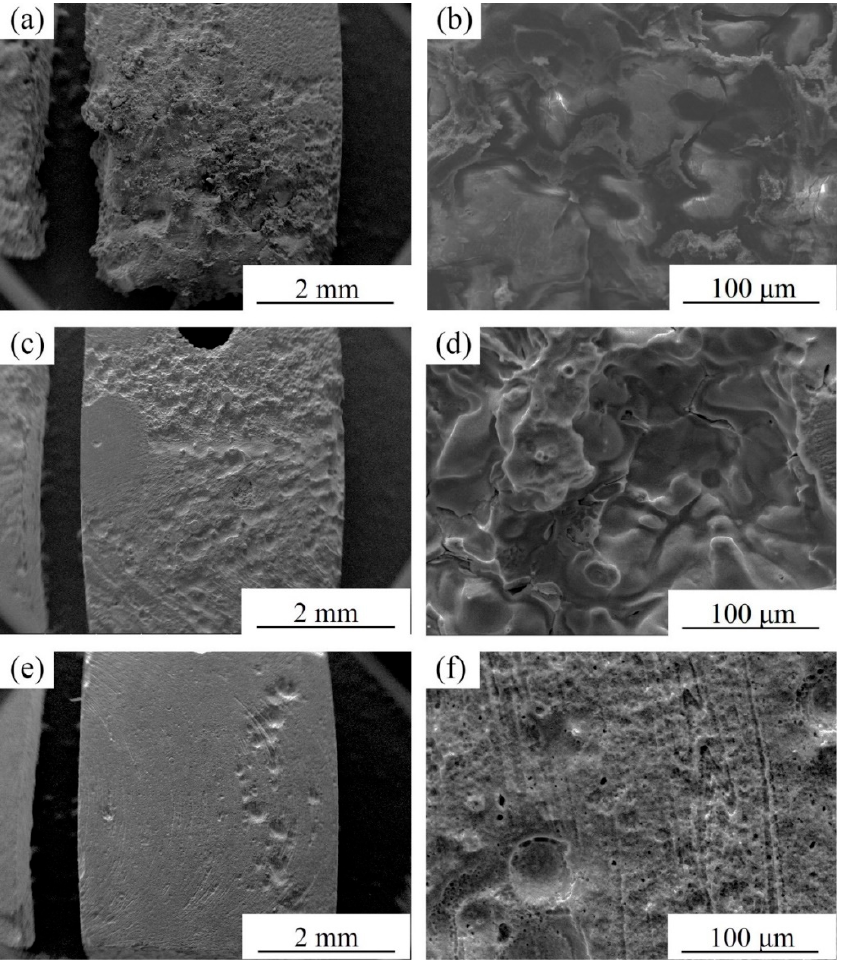
Figure 12. Corrosion morphologies of ( a , b ) BM, ( c , d ) FSP-WE43, and ( e , f ) WE43/nHA specimens after immersion in SBF for 72 h at 37 °C (without corrosion products).